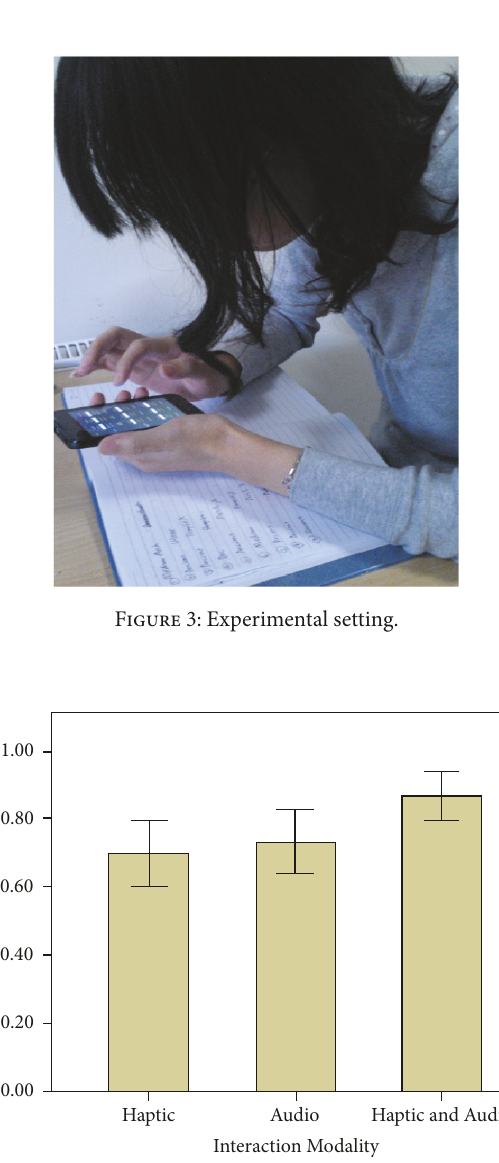
We performed a repeated-measures ANOVA for Modal- ity × Amplitude × Rhythm. A significant effect was found ( 𝑝 > 0.05 ) for Interaction modality ( 𝐹 1,27 = 3.40 , 𝑝 < 0.05 ). Neither Amplitude nor Rhythm had an effect ( 𝑝 > 0.05 ), and no significant interaction effect was found ( 𝑝 > 0.05 ).